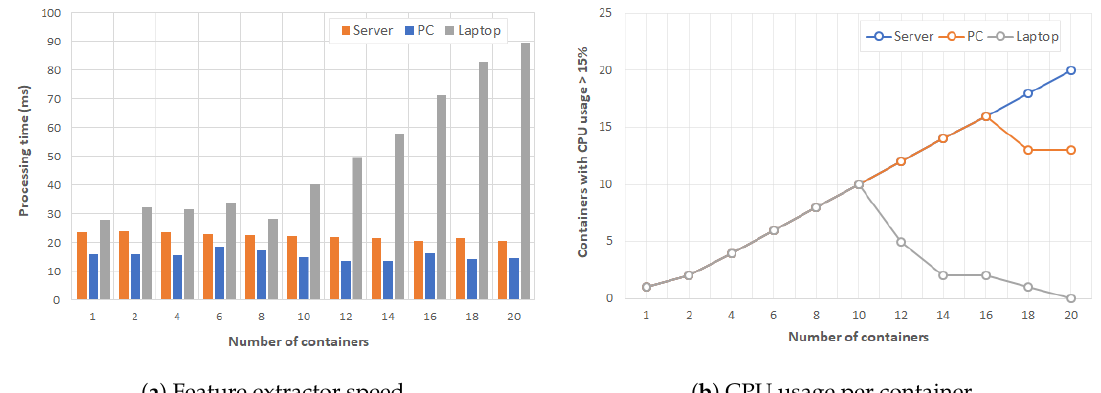
Figure 5. Performance results for Automatic Speaker Recognition application in Docker